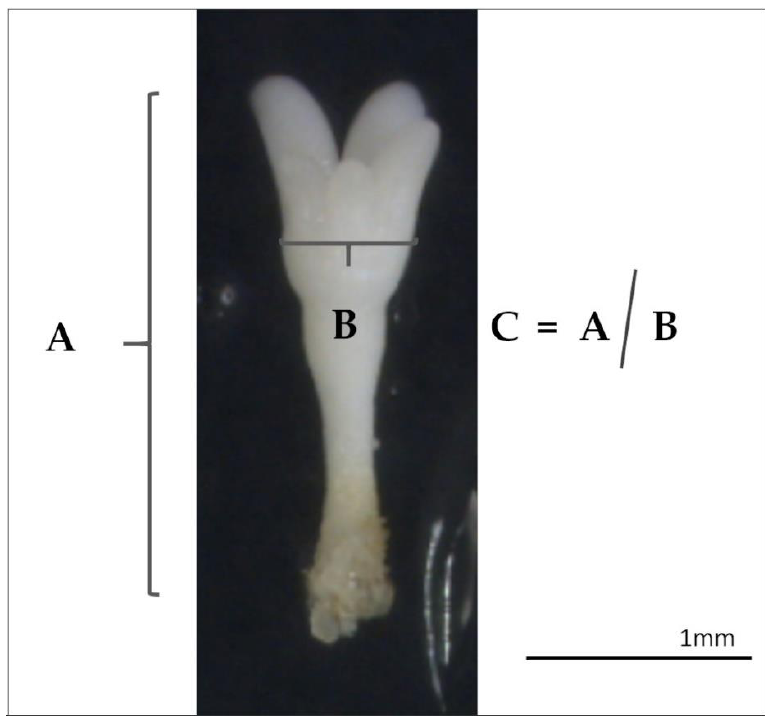
Figure 1. Somatic embryo showing how the measurements were performed: ( A ) Length, ( B ) width, and ( C ) the ratio between (A) and (B).